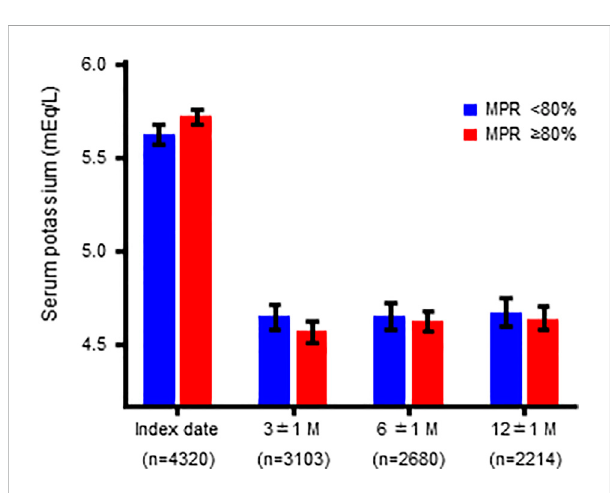
Serum potassium levels at the index date and at 3, 6, and 12 months in patients strati fi ed by MPR (overall population).